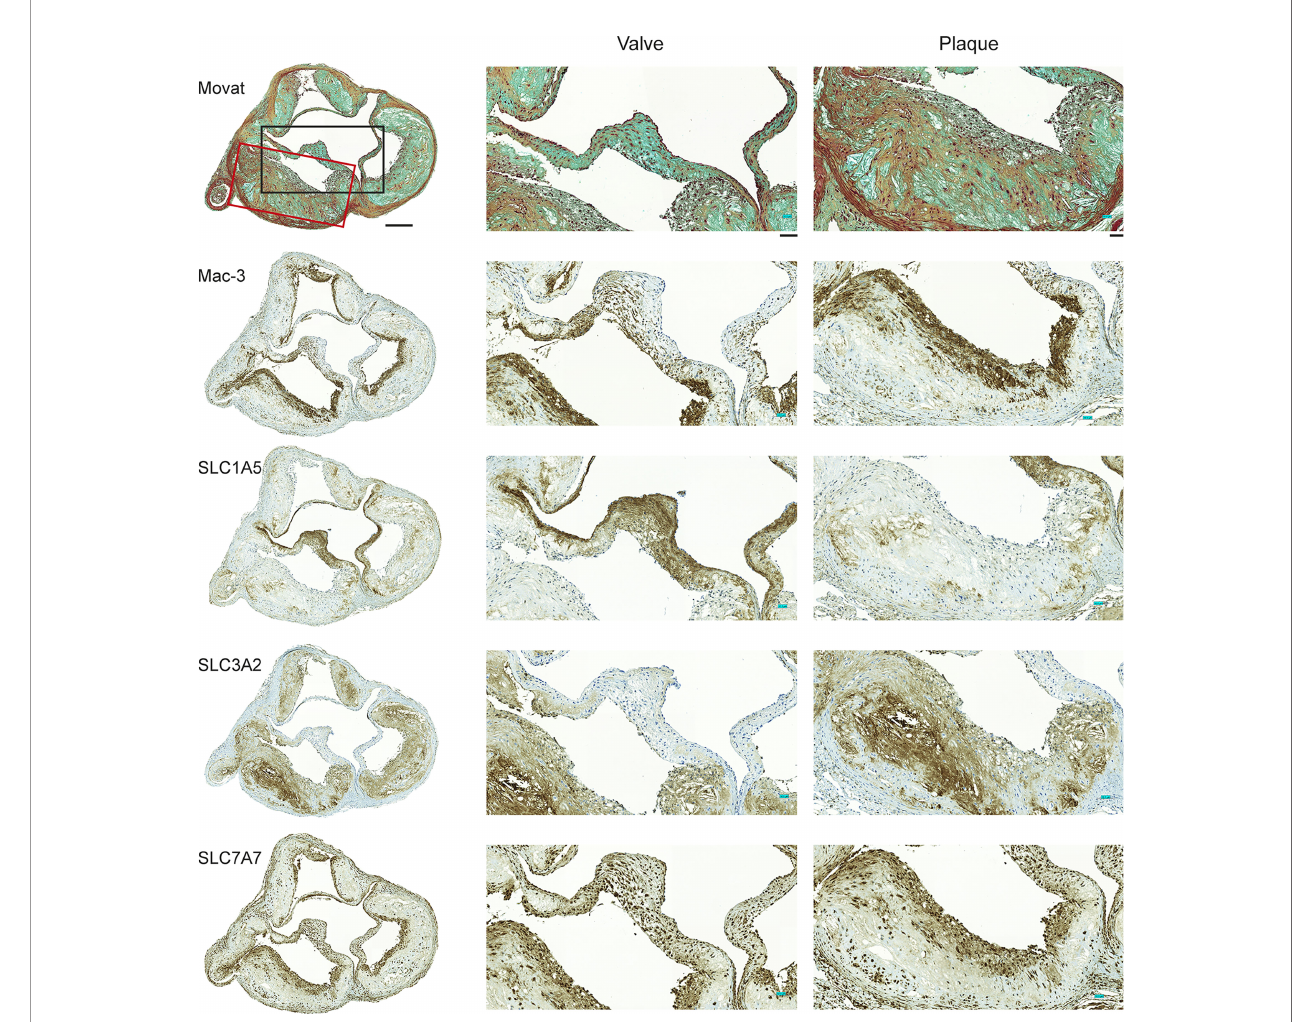
FIGURE 2 | Expression of Mac-3 and glutamine transporters by mouse aortic plaque macrophages. Movat ’ s pentachrome staining of the aortic root demonstrates that atherosclerotic plaques were composed mostly of a fi brous cap and a necrotic region. Immunostaining of adjacent sections shows that Mac-3-positive macrophages are also positive for glutamine transporters SLC1A5, SLC3A2, and SLC7A7. Higher magni fi cations of the valve and plaque vessel regions are shown in the black and red rectangular boxes, respectively. Expression of SLC1A5 is prominent in the aortic valve region but not in the vessel plaque region. Expression of SLC3A2 is absent from the valve region but present in the vessel plaque region. Expression of SLC7A7 is clear in both the valve and vessel plaque regions. Scale bar = 200 µm; zoomed region scale bar = 50